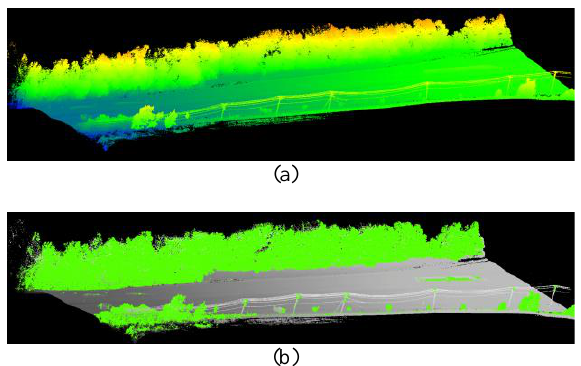
Figure 5. USA suburban environment; (a) collected LiDAR point clouds, (b) the output of the proposed algorithm.